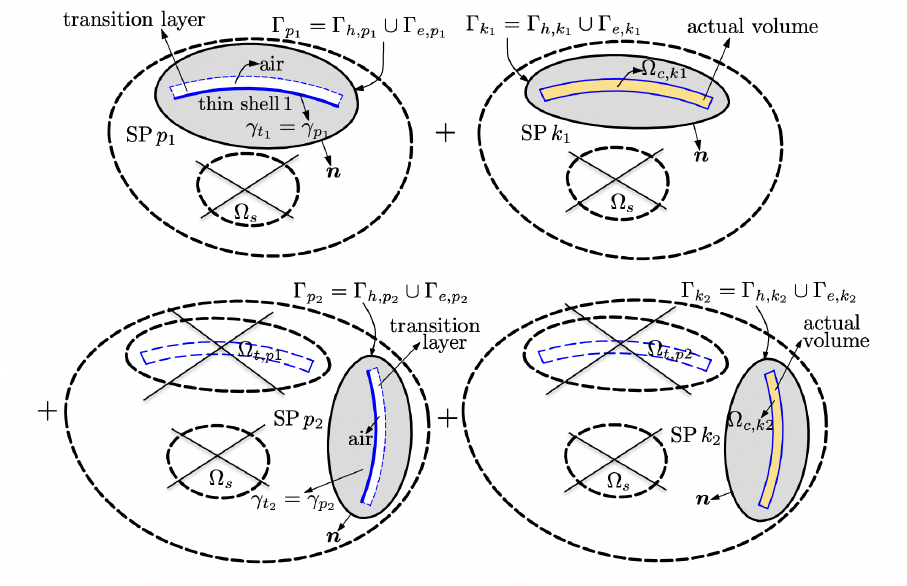
Fig. 2. Dividing a full model into several SPs: SP u + SP p 1 + SP k 1 + SP p 2 + SP k 2 .